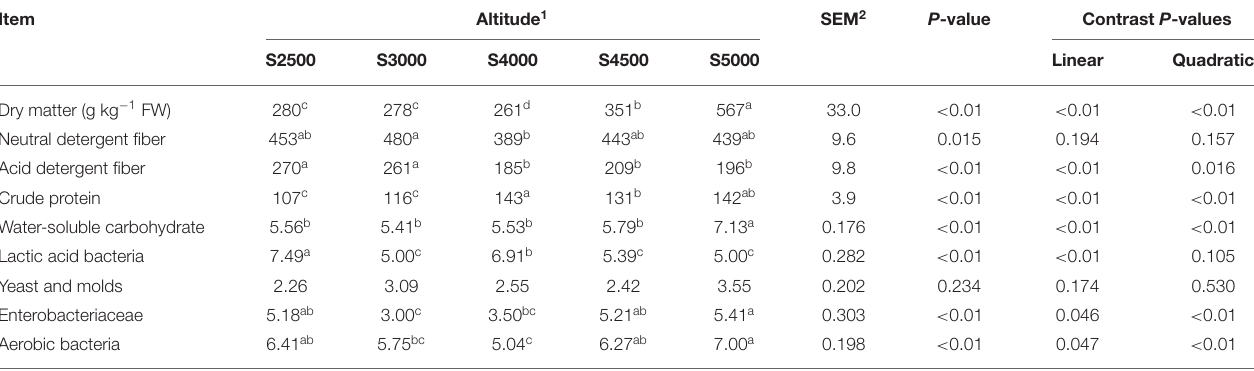
TABLE 2 | The chemical composition (g kg − 1 DM basis unless stated otherwise) and microbial populations (log 10 CFU g − 1 FW) of ensiled K. pygmaea along the elevation gradient on the Tibetan Plateau. Item Altitude 1 SEM 2 P -value Contrast P -values S2500 S3000 S4000 S4500 S5000 Linear